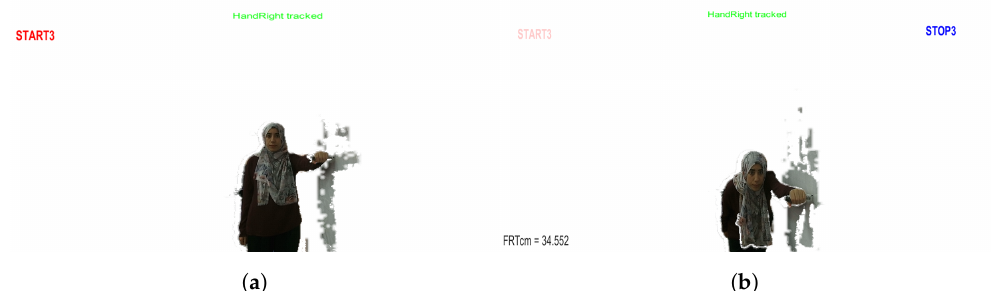
Figure 3. Screenshot of the system during the FRT performance: ( a ) Initial position and ( b ) Last